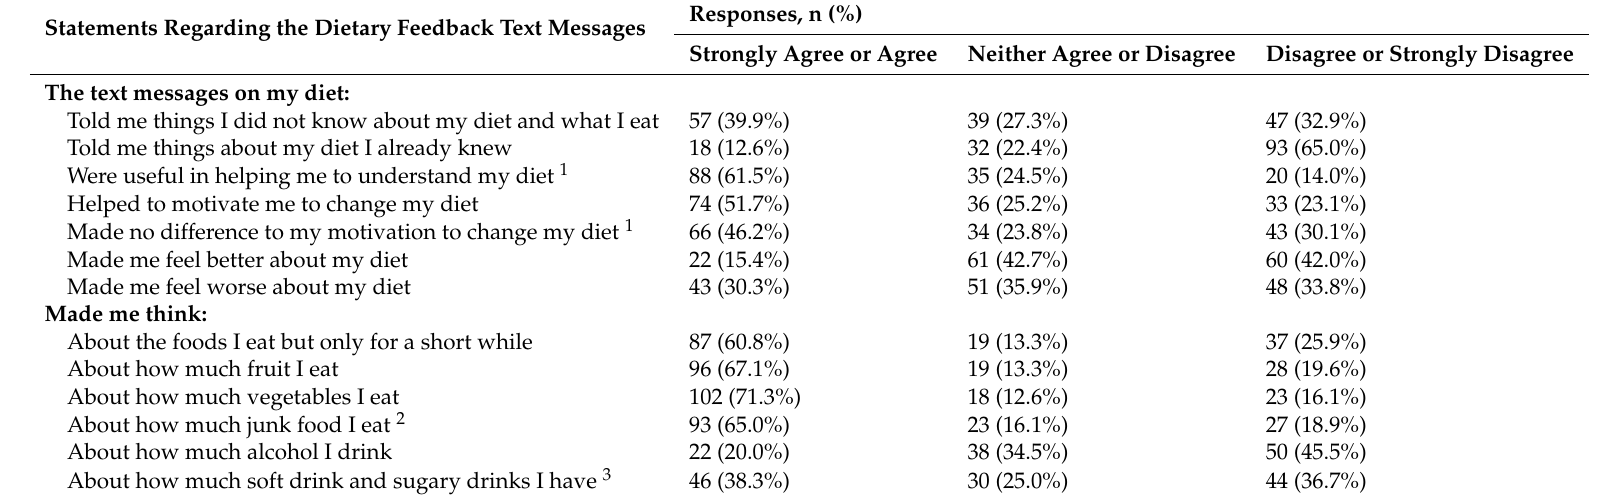
Table 2. Comparison of perceptions for intervention group participants (n = 143) regarding the text message dietary